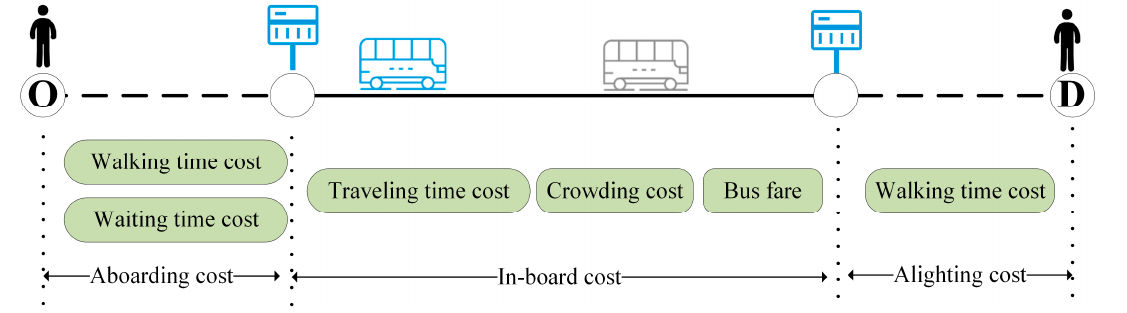
Figure 3. Generalized travel cost diagram of bus.